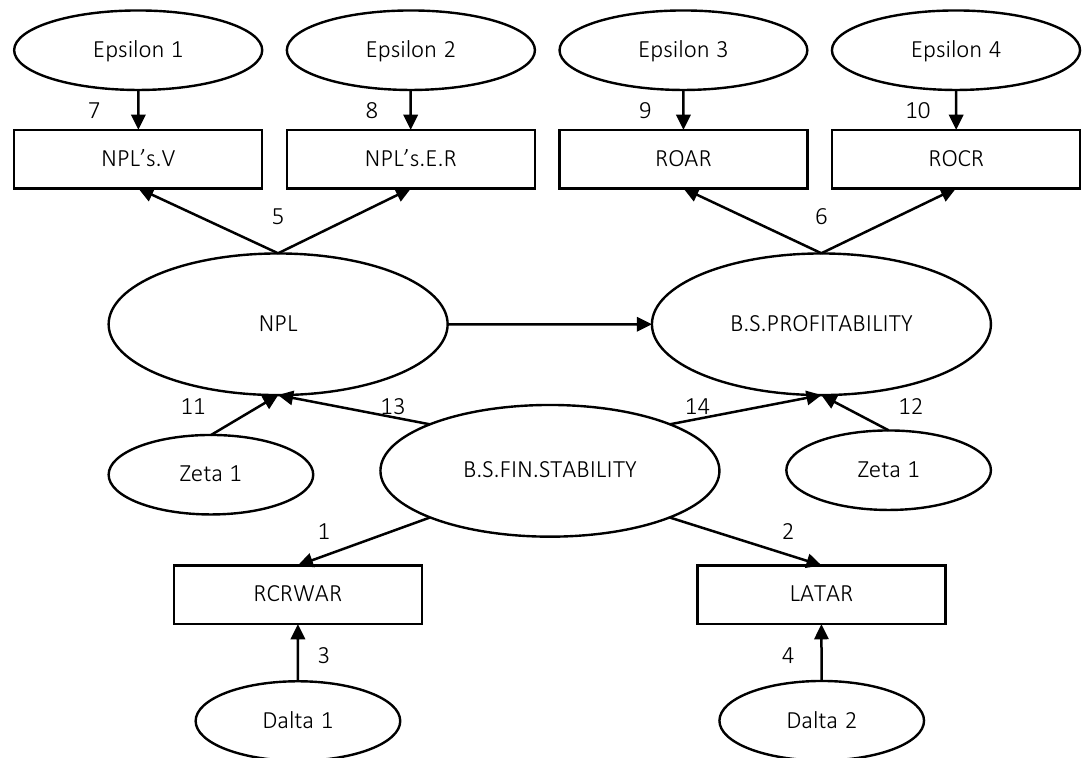
Figure 1. Path diagram to study the relationship between non-performing loans of banking institutions, profitability and financial stability of the Ukrainian banking